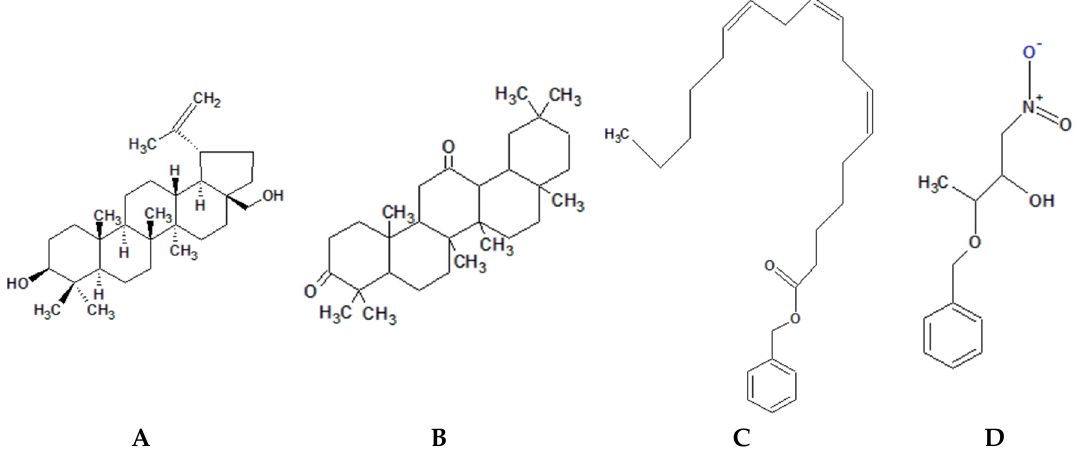
Figure 3. Chemical structure of phytochemicals with S. mutans quorum sensing inhibition activity. ( A ): Betulin; ( B ): Oleanane-3,12-dione; ( C ): Benzyl (6 Z ,9 Z ,12 Z )-6,9,12-octadecatrienoate; ( D ): 3-Benzyloxy-1-nitrobutan-2-ol.